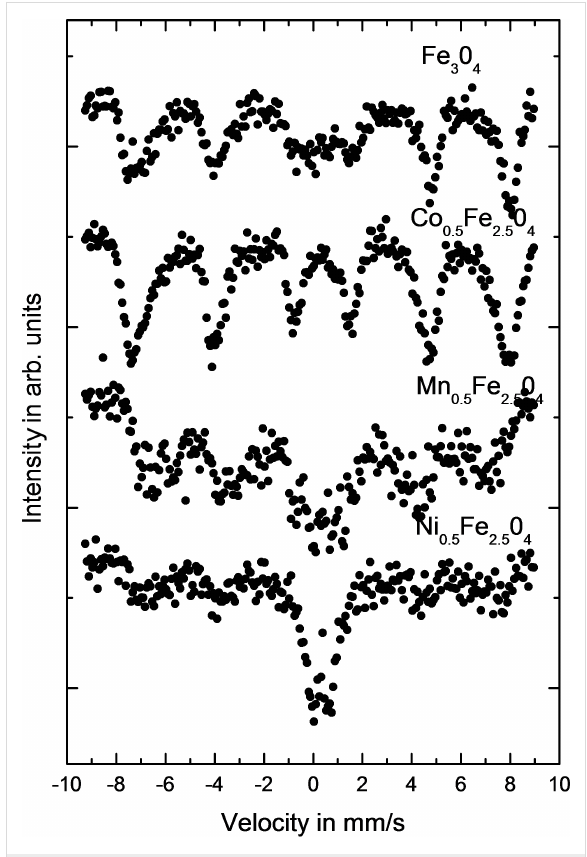
Figure 4: Mössbauer spectra of various ferrite